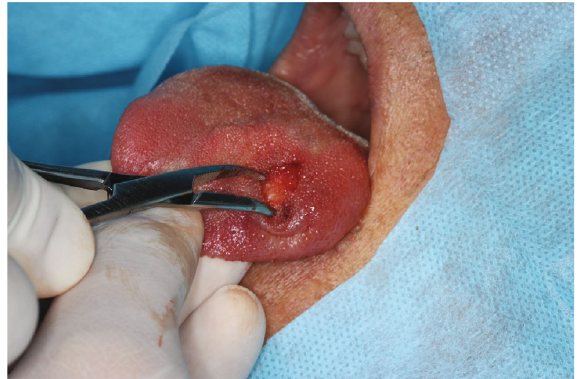
Figure 3: Surgical access performed through a linear incision in the lingual dorsum on the left side, close to the most super fi cial region of the lesion.